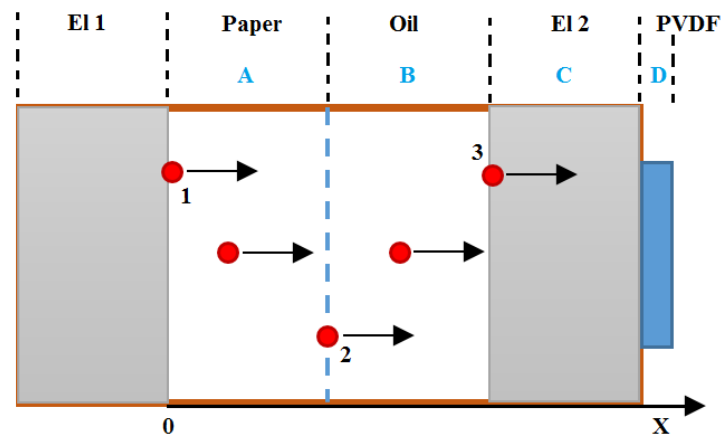
Figure 22. Sound wave propagation in oil and oil immersed paper.